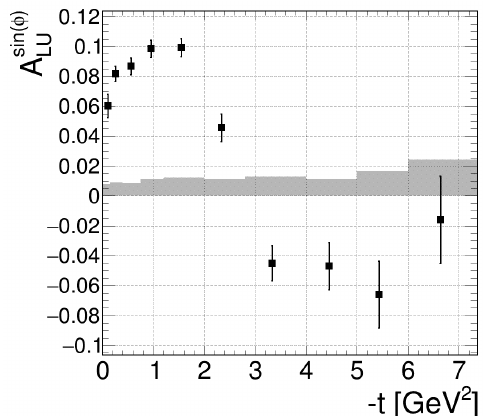
φ as function of − t . The shaded area represents the systematic uncer- Figure 2: A sin LU tainty of the measurement. The figure is taken from [ 13 ] .